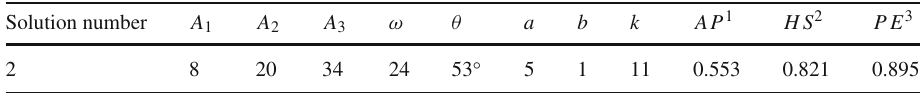
Table 6 The corresponding parameters and objective values of the final selected solution obtained by MOWOA